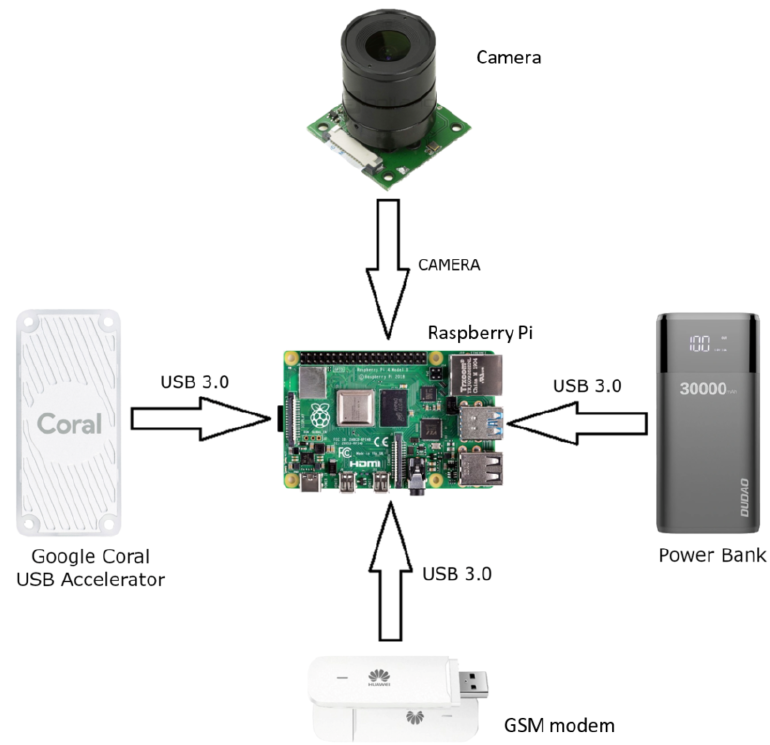
Figure 1. Overview of the IoT device used for monitoring a